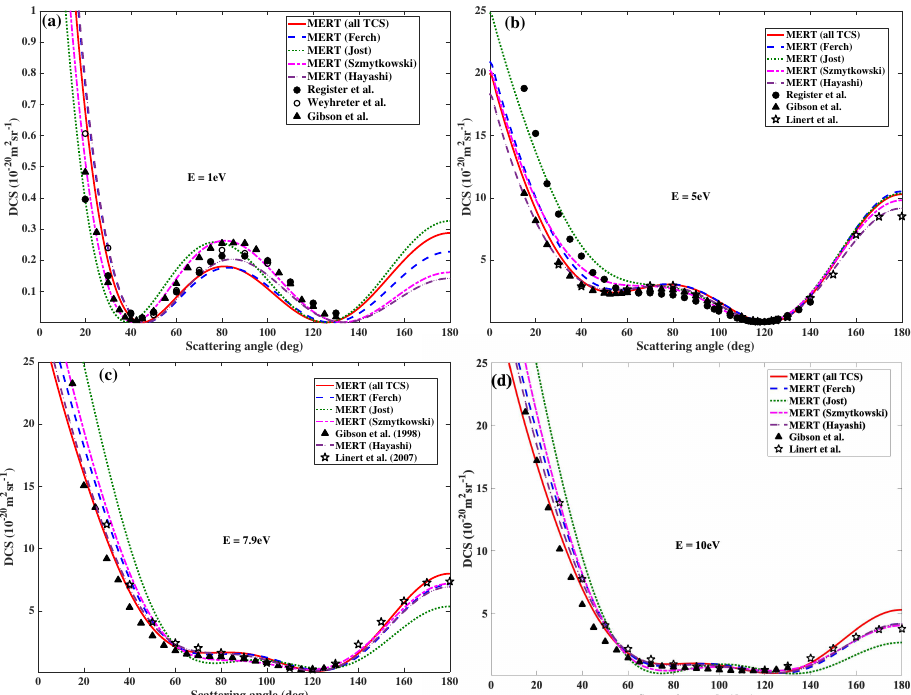
Figure 7. Angular dependencies of MERT − derived differential cross − sections at ( a ) 1, ( b ) 5, ( c ) 7.9, and ( d ) 10 eV for e − − Xe scattering. The present results are compared with experimental data of Register et al. [76], Gibson et al. [77], Linert et al. [78], and Weyhreter et al.